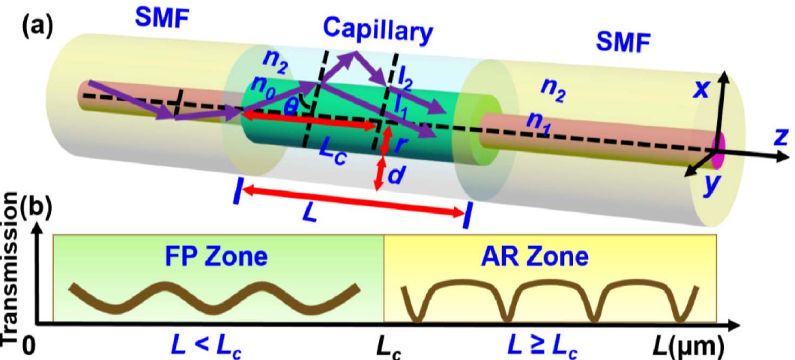
Figure 2. Schematic illustration of ( a ) optical pathways in the SMF–capillary–SMF structure and ( b ) transmission spectra as the increase of capillary length. [Reprinted/Adapted] with permission from [12] © The Optical Society.